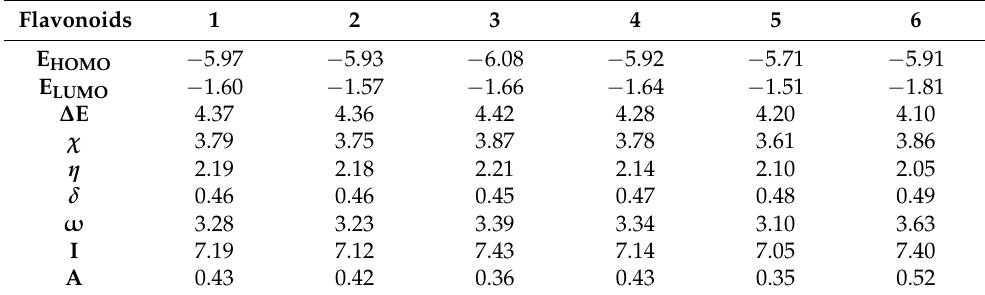
Table 1. Calculated electronegativity ( χ ), global hardness ( η ), softness ( δ ), global electrophilicity index ( ω ), the ionization potential (I), and the electron affinity (A) (eV) of investigated flavonoids 1 – 6 . Flavonoids